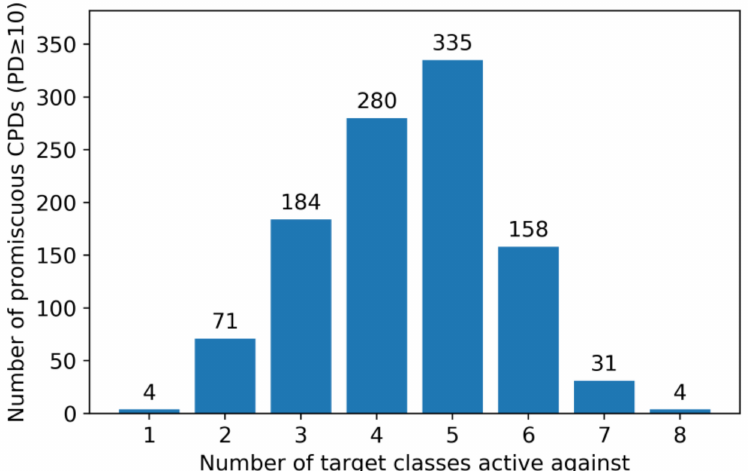
Figure 2. The histogram shows the distribution of highly promiscuous compounds (PD ≥ 10) over increasing numbers of target classes. Only four highly promiscuous compounds were active against 10 or more targets from a single class and four others against targets from all eight